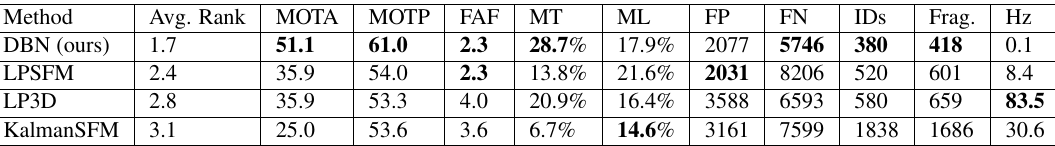
Figure 5. Qualitative results shown for example images from the two test